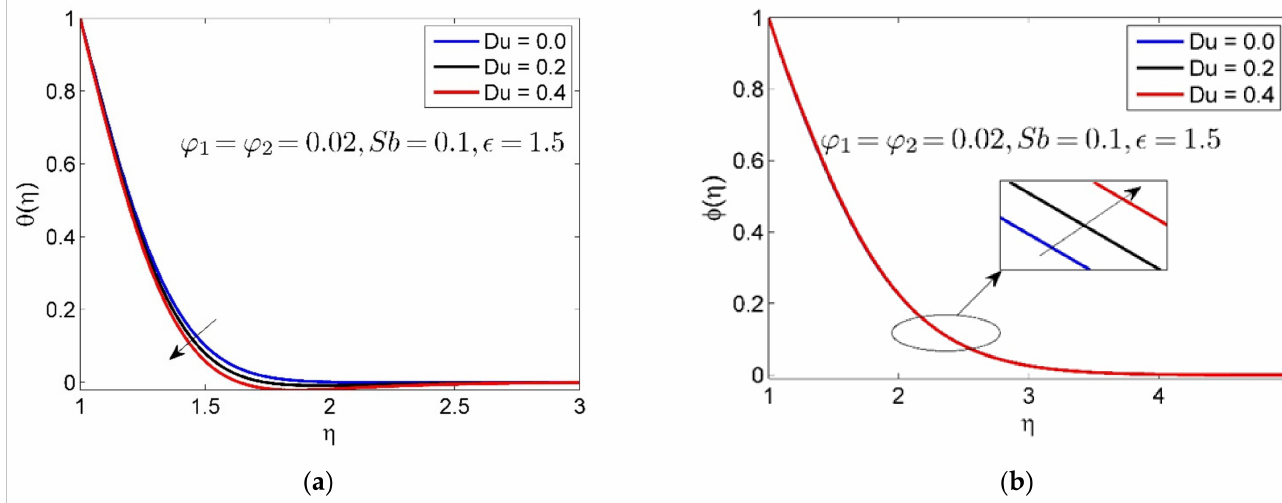
Figure 5. Influences of Du on θ ( η ) and φ ( η )